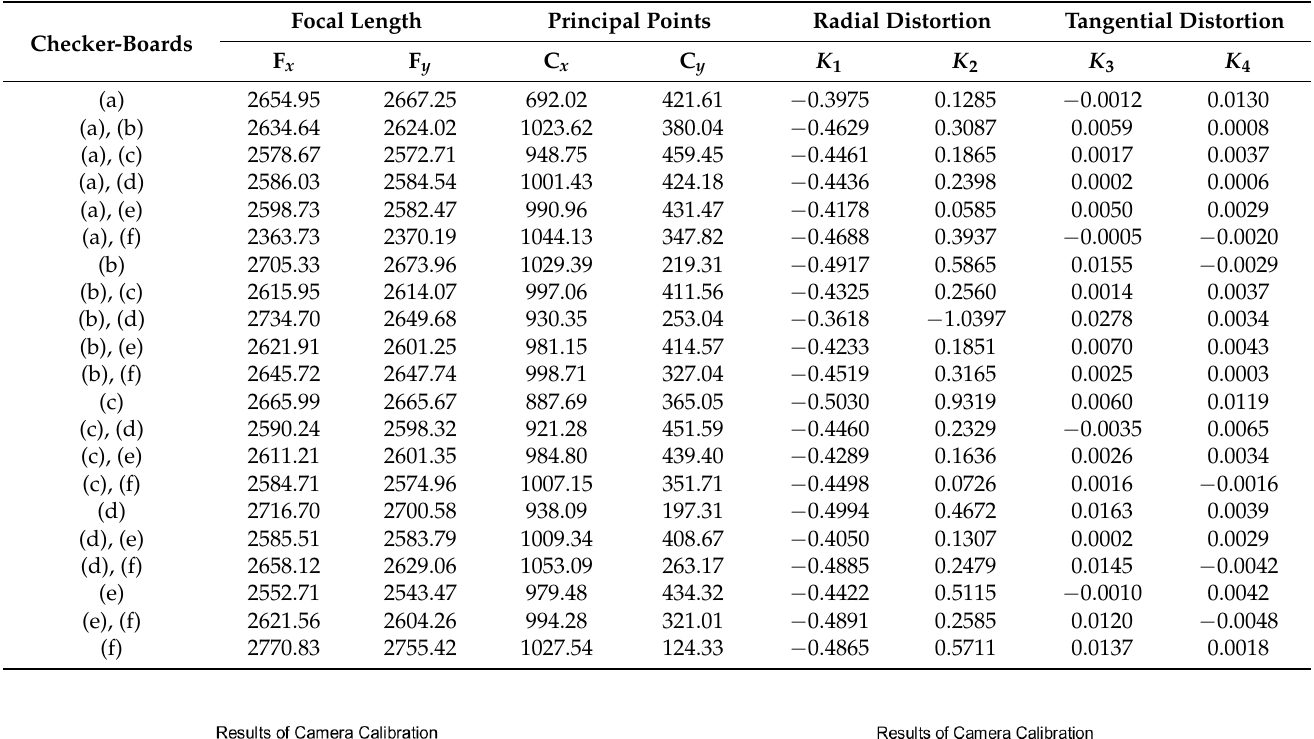
Table 1. Estimated intrinsic parameters using different sets of checkerboards. The checkerboard ‘(a)’ denotes the size and configuration of the checkerboard presented in Figure 4a.